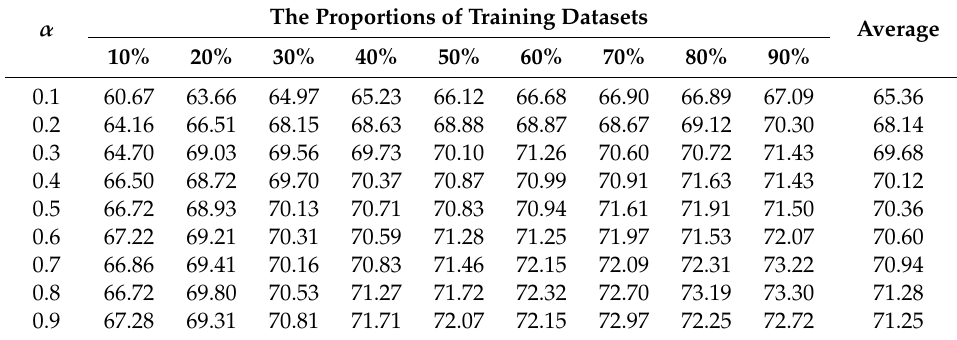
Table 7. Influence of triplet weight on the Citeseer dataset.